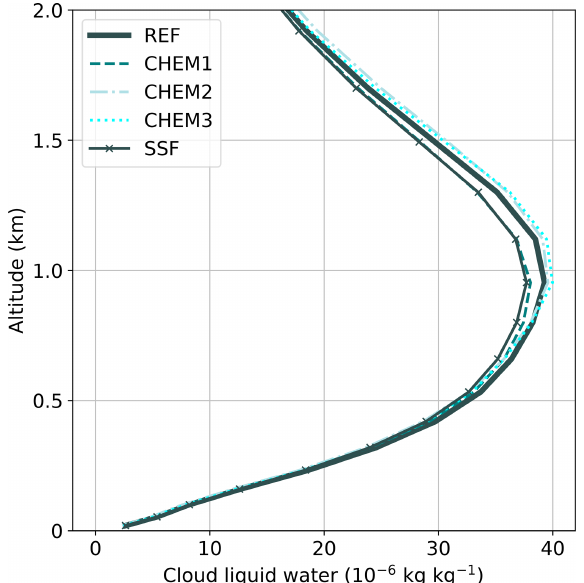
Figure 9. The mass fraction of cloud liquid water in DJF between 40 and 60 ◦ S in the lowest 2km of the atmosphere.